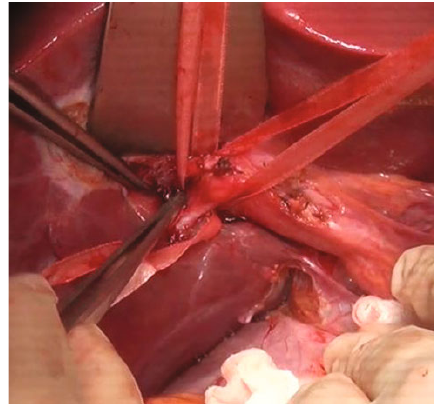
Figure 5: Dissecting right Glissonean pedicle and anterior and posterior Glissonean